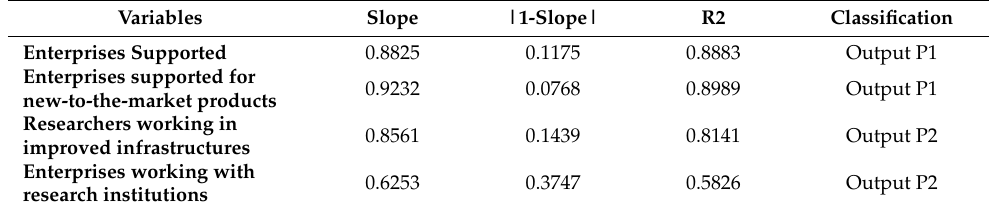
Figure 7. Sensitivity analysis for ES — number of enterprises supported ( a ), ESNMP — enterprises supported for new-to-the-markets products ( b ), RWII — researchers working in improved infrastructures ( c ) and EWRI — enterprises working with research institutions ( d ). Note: The x -axis of subfigures ( a – d ) represent the original efficiency score, and the y-axis represents the recalculated efficiency by omitting one variable at a time. Solid blue lines represent the best fit to the data. Table 10. Sensitivity analysis